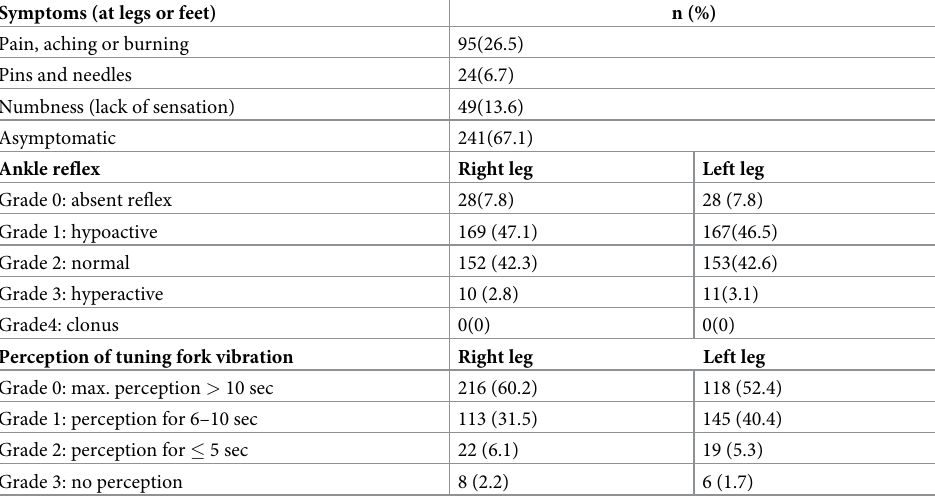
Table 3. Prevalence of sign and symptoms consistent with HIV-SN among adult HIV patient 2017, Ethiopia. Symptoms (at legs or feet) n (%) Pain, aching or burning